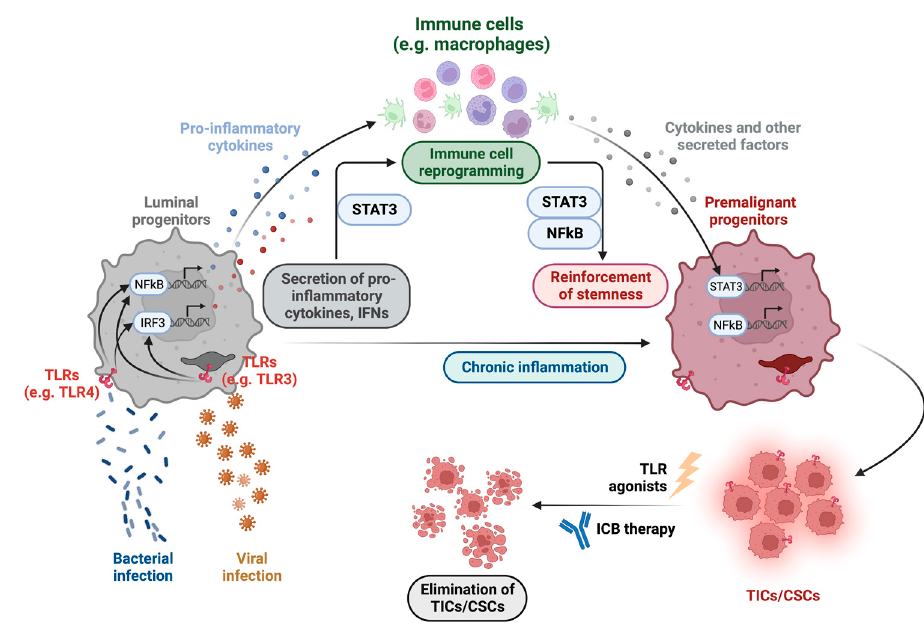
Figure 2. Schematic diagram depicting the potential role of innate immune program/Toll-like receptor (TLR) pathways in evolution of TICs/CSCs from their corresponding cellular origins (i.e., luminal progenitors in the breast, prostate, and FT).